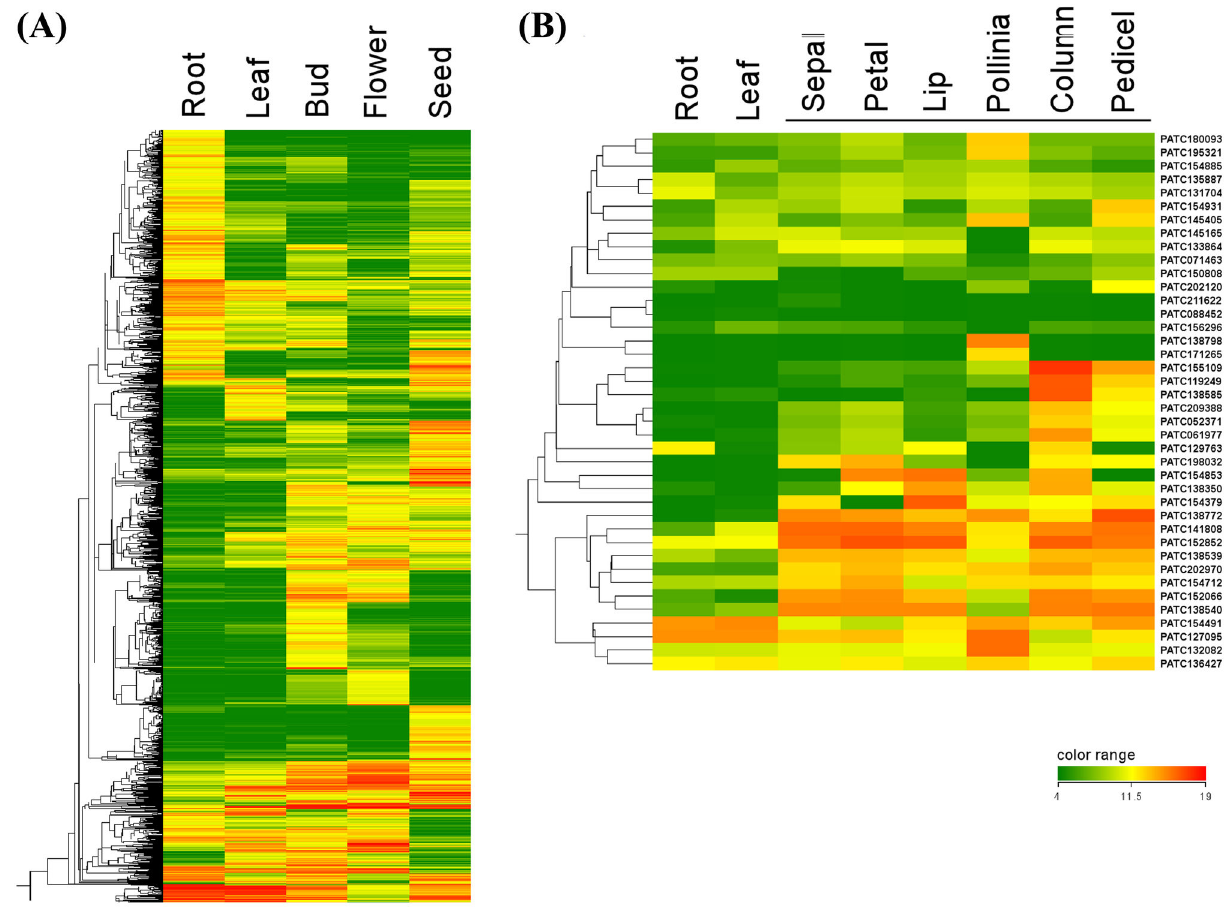
Figure 1. Gene clustering analyses of tissue-specific expression patterns in Phalaenopsis orchid. Genes that exhibited a greater than 4-fold change after microarray clustering analysis are shown. (A) Overall gene clustering of genes with greater than 4- fold change in expression was derived from a series of microarray analyses of a variety of Phalaenopsis tissues including root, leaf, flower bud, flower (full bloom) and germinating seed. (B) Gene clustering of Phalaenopsis orchid MADS box transcription factor encoding genes in various floral organ tissues. Only genes with levels of expression above the array detection in flower tissues are